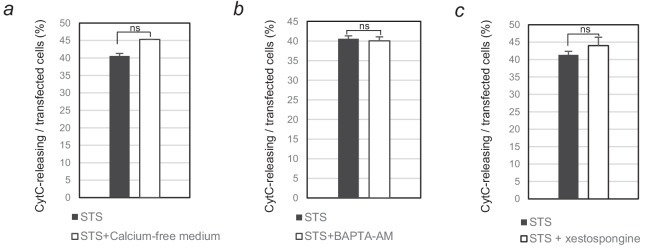
Involvement of calcium flux in staurosporine-induced apoptosis.(a–c) MCF10A epithelial cells were starved overnight in classical or calcium-free medium (a) or in the presence or absence of 10 µM calcium chelator BAPTA-AM (b). The next day, they were treated for 6 hr with 1 µM staurosporine to induce apoptosis in presence or absence of IP3R inhibitor xestospongin-B (c). Immunofluorescence staining was performed with an anti-cytochrome c antibody to detect apoptotic cells. Nuclei were detected with Hoechst. At least 100 cells were counted per well (n = 3;± S.D). ns, non-significant; determined by Student’s t test.